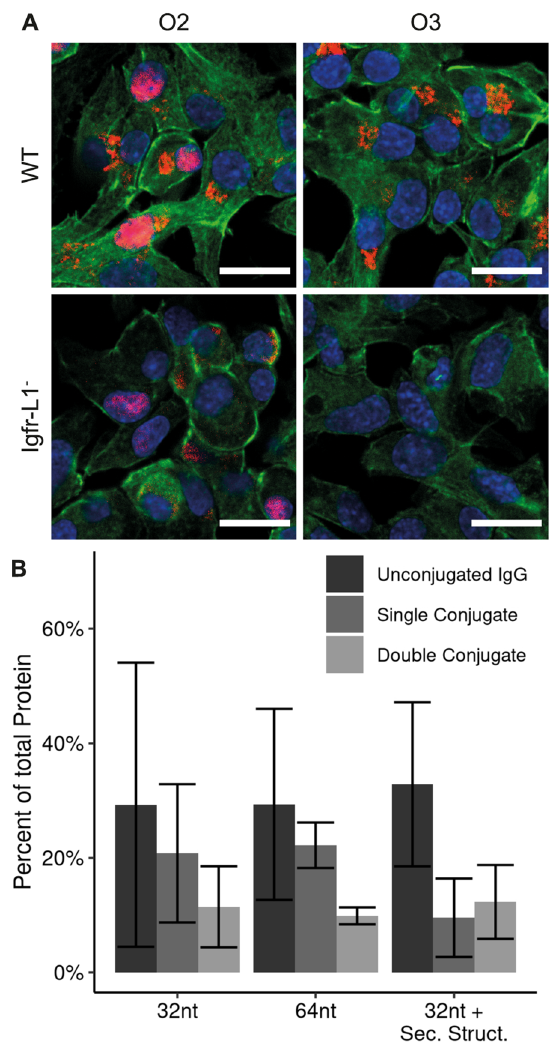
Figure 4. Influence of the oligonucleotide length and secondary structure on the antibody-oligonucleotide conjugation yield and specificity. ( A ) IF images of single O2 and O3 conjugated anti-Igfr-L1 in wild type and Igfr-L1 knock out Min6 cells. Scale bar: 20 µ m. ( B ) Comparison of the influence of oligonucleotides with different compositions on the conjugation yield. Comparing oligonucleotides with a length of 32 nt and 64 nt, no conjugation differences were observed. A secondary structure within the oligonucleotide reduced the fraction of single oligonucleotide conjugate antibody by about 56%. Error bars represent standard